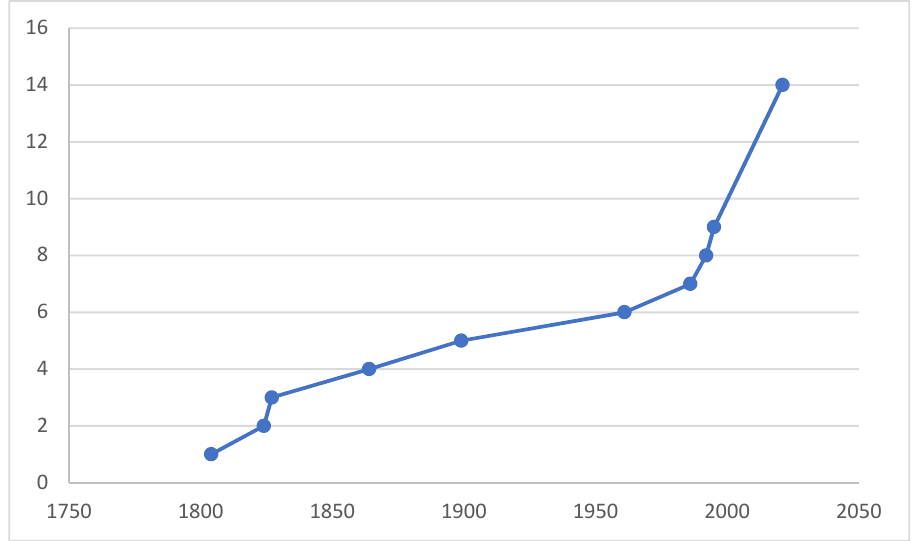
Figure 1. A cumulative curve of number of valid species of Microphor described from West Palaearctic, incl. two species from Central Asia.